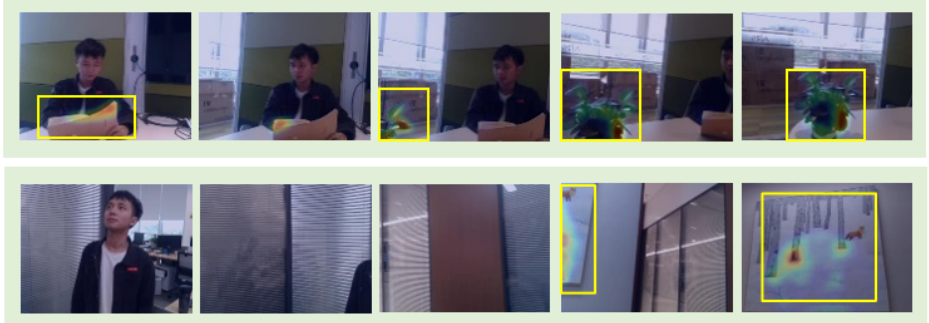
Figure 7. Illustration of cross-frame gaze estimation.